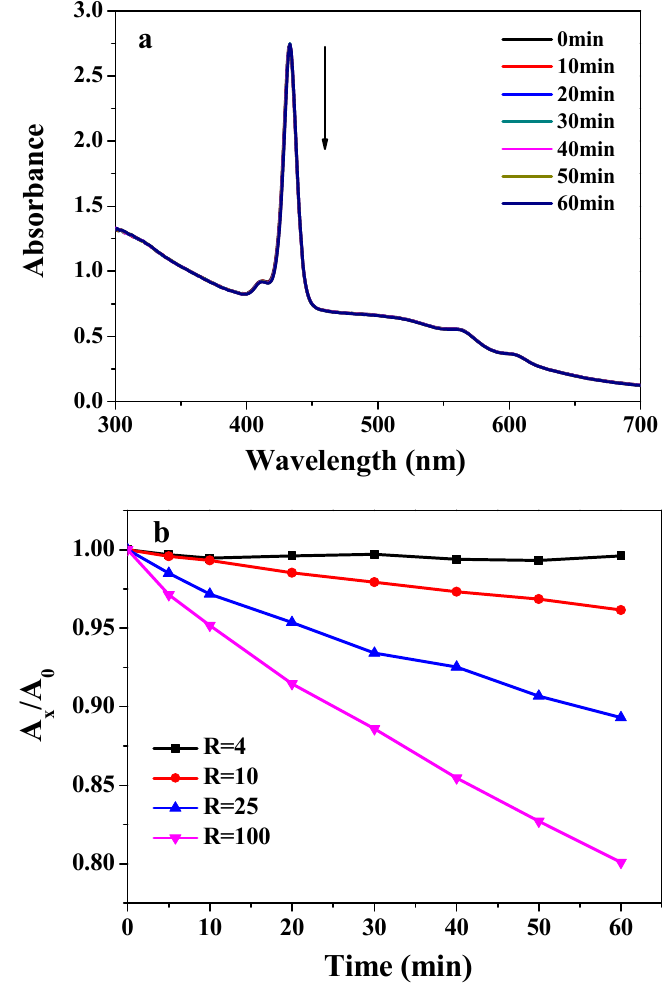
Figure 5. ( a ) Changes in the UV-visible absorption spectra of ZnTPPS and AuNPs in the complex micelles (R = 4) with irradiation time. ( b ) Kinetic profiles of the photodegradation of ZnTPPS and AuNPs in the complex micelles with different R values.